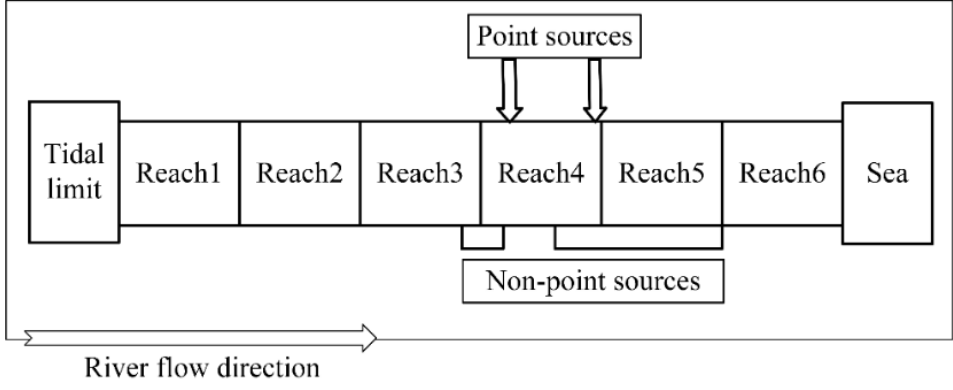
Figure 2. Segmentation of the Shoalhaven River downstream of Burrier into reaches for QUAL2K. QUAL2K was used in this study to calculate water quality variables in the Shoalhaven River estuary. The model outputs of water temperature, DO concentration, DO saturation, the re-aeration coefficient ( k a ), TN concentration, and TP concentration are shown in the result section. Full details of QUAL2K and all its variables are given in the